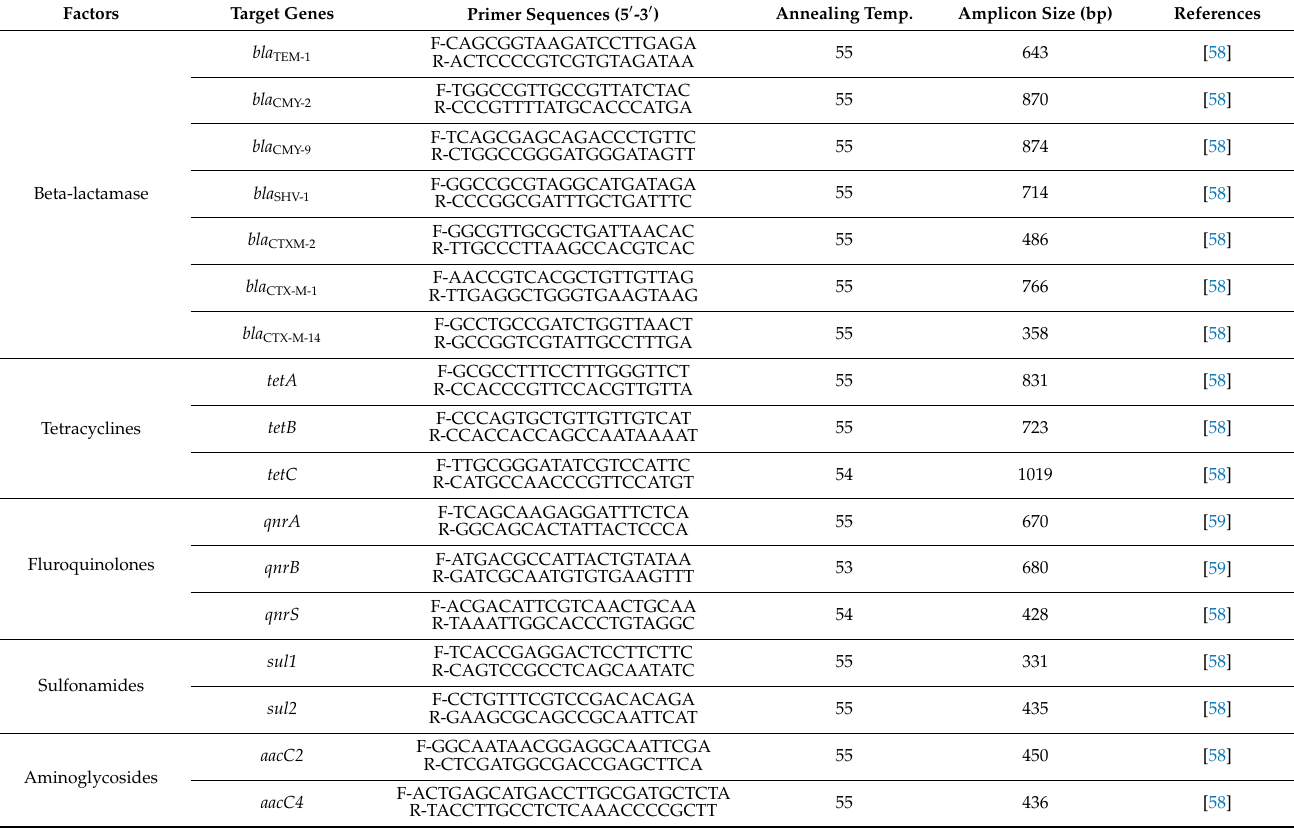
Table 3. Primers used in the present study for detecting Citrobacter spp. and different antibiotic resistance genes in C. freundii isolates from cloacal swabs of